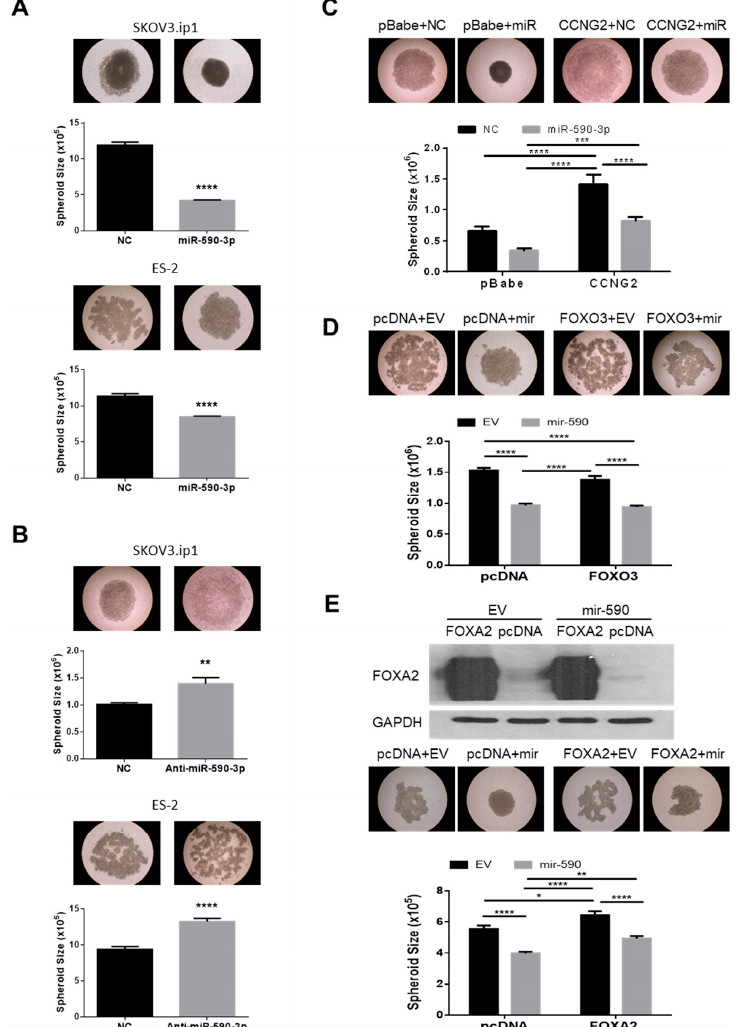
Figure 5. miR-590-3p promoted the formation of compact spheroids. ( A ) The overexpression of miR-590-3p induced compact spheroid formation in hanging drop culture. Transient transfection of miR-590-3p into both SKOV3.ip1 (top) and ES-2 (bottom) cells resulted in the formation of tight, compact, and smaller spheroids when compared to the non-targeting control (NC) ( n = 12–21). ( B ) Inhibition of miR-590-3p blocked compact spheroid formation. Transient transfection of anti-miR-590-3p disrupted the formation of compact spheroids ( n = 18–21). ( C ) Overexpression of CCNG2 reversed the effect of miR-590-3p in spheroid formation. Control or CCNG2 stable SKOV3.ip1 cells were transiently transfected with either miR-590-3p or NC, and hanging drop cultures were performed. In control cells, miR-590-3p overexpression resulted in the formation of compact spheroids. CCNG2 stable cells formed loose spheroids and reduced the effect of miR-590-3p on spheroid formation ( n = 12–15). ( D ) Control and mir-590 stable ES-2 cells were transiently transfected with either FOXO3 or its empty vector, pcDNA3. FOXO3 overexpression partially inhibited the ability of mir-590 to form the compact spheroids, but had no effect on the size of the spheroids ( n = 16–20). ( E ) FOXA2 reduced the effect of mir-590 on spheroid formation. Transfection of FOXA2 into control and mir-590-overexpressing SKOV3.ip1 resulted in the formation of larger and less compact spheroids (bottom) ( n = 16–20). Overexpression of FOXA2 after transfection was confirmed by Western blotting (top). Data represent the mean ± SEM. Statistical analyses were performed using t -test (A and B), or two-way ANOVA/Student–Newman–Keuls test. * p < 0.05, ** p < 0.01, *** p < 0.001, **** p <